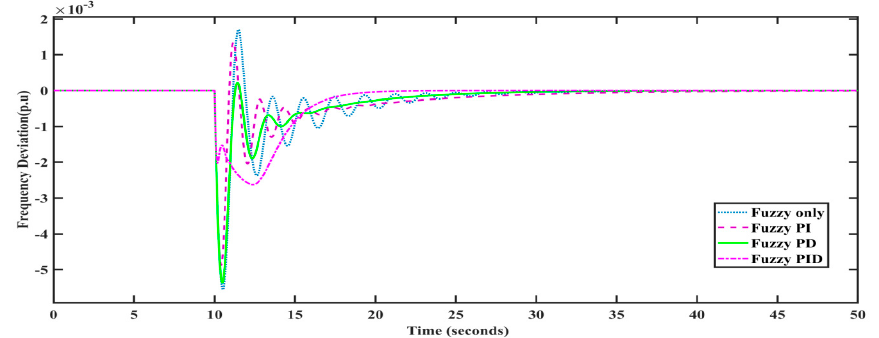
Figure 14. Dynamic response comparison of different control configurations of IHPS frequency change with step input of 10% increase in load.